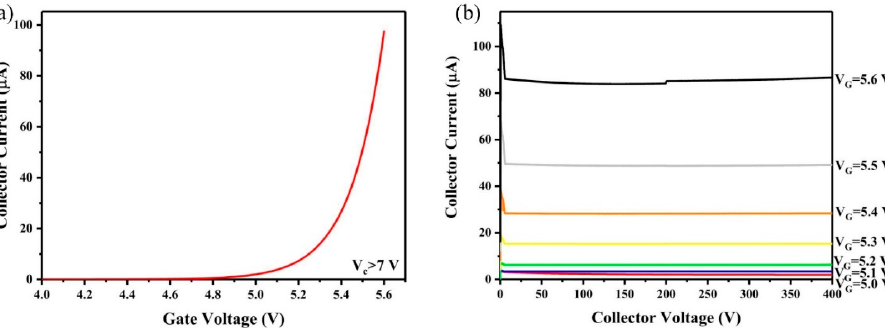
Figure 6. ( a ) Transfer and ( b ) output characteristics of the IGBT used in our study. Table 1. The current stability of CNT electron sources reported in references.